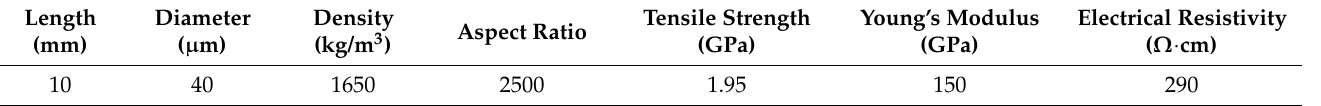
Table 1. Properties of the carbon fibers. Figure 3. TEM microscopy of amorphous calcium silicate hydrate: ( a ) morphology of amorphous calcium silicate hy- drate; ( b ) selected area electron diffraction (SAED) pattern.